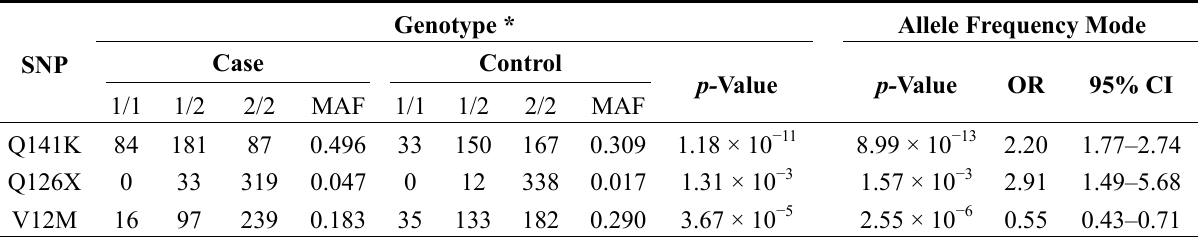
Table 1. Association analysis of ABCG2 variants in gout patients. MAF, minor allele